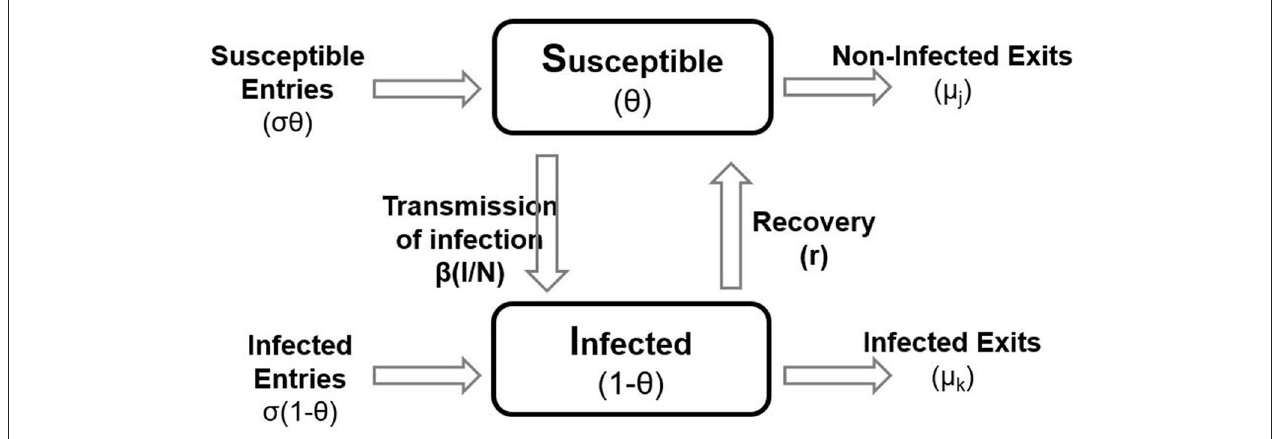
FIGURE 1 | A schematic representation of the susceptible–infected–susceptible model used for the estimation of the transmission parameter, β in the population. The boxes represent the state variables and the arrows represent the flow rates between them. Lettering represents the variables and parameters in the model.